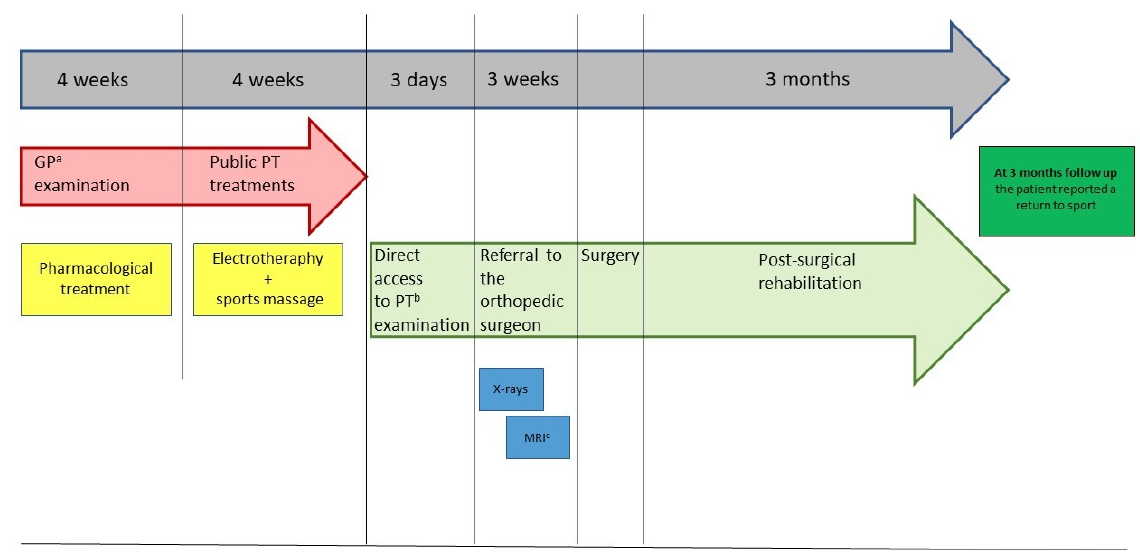
Figure 4. Timeline: a : general practitioner; b : physical therapist; c : magnetic resonance imaging.